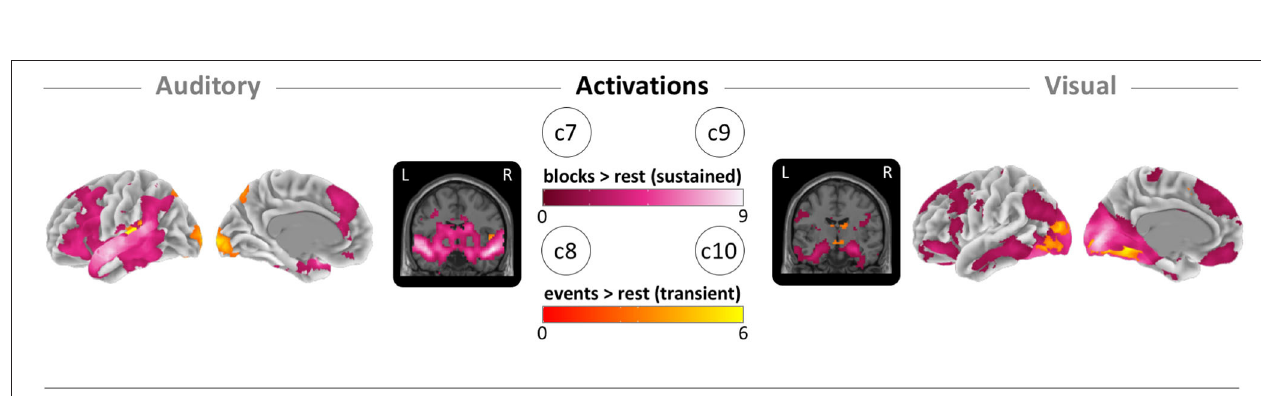
FIGURE 5 | Brain maps of block-related (sustained) and event-related (transient) activations. (c7) Auditory block vs. rest activation (pink). (c8) Auditory event vs. rest activation (orange). (c9) Visual block vs. rest activation (pink). (c10) Visual block vs. rest activation (orange). Brain activity is shown at a threshold of p < 0.05 [false discovery rate (FDR) corrected], and the color intensity shows the t -value. Contrast maps are uploaded under